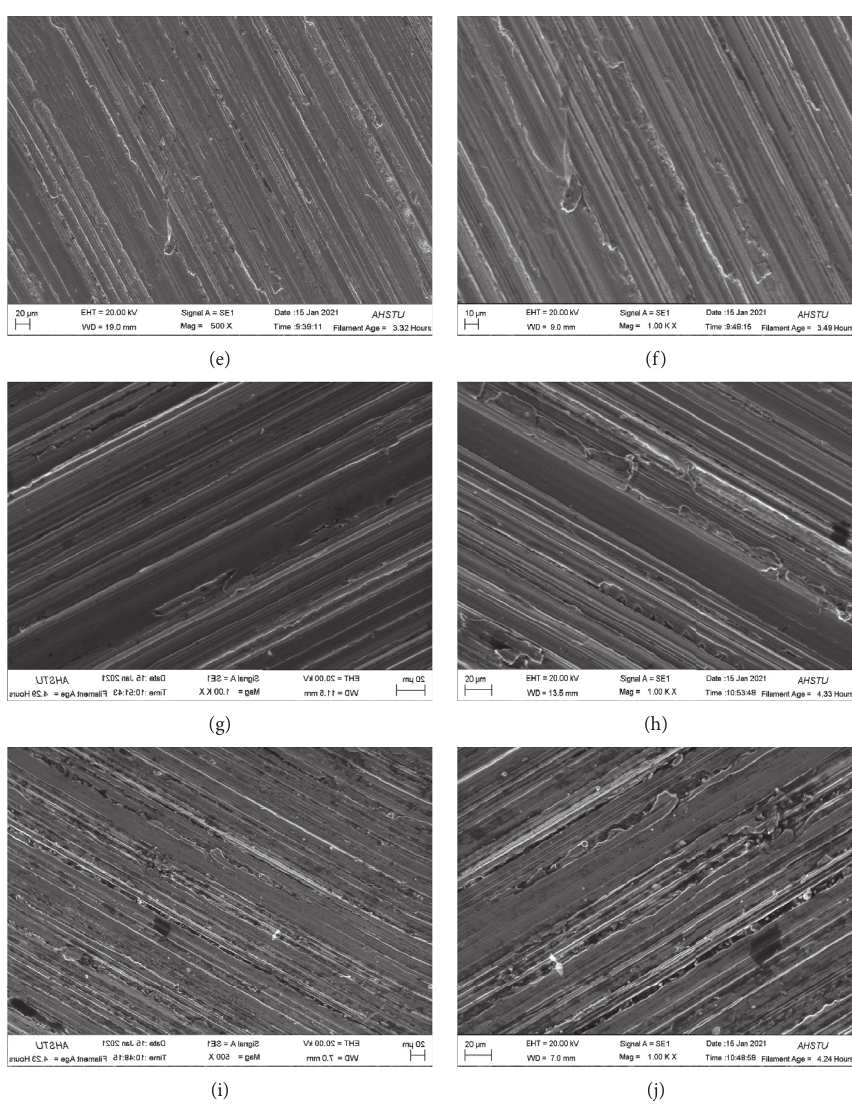
Figure 13: Morphology of the sample at 500 (a, c, e, g, i) and 1000 (b, d, f, h, j) times magnifications subjected to wear tests at (a, b) 20N, (c, d)25 N, (e, f) 30 N, (g, h) 35N, and (i, j) 40N